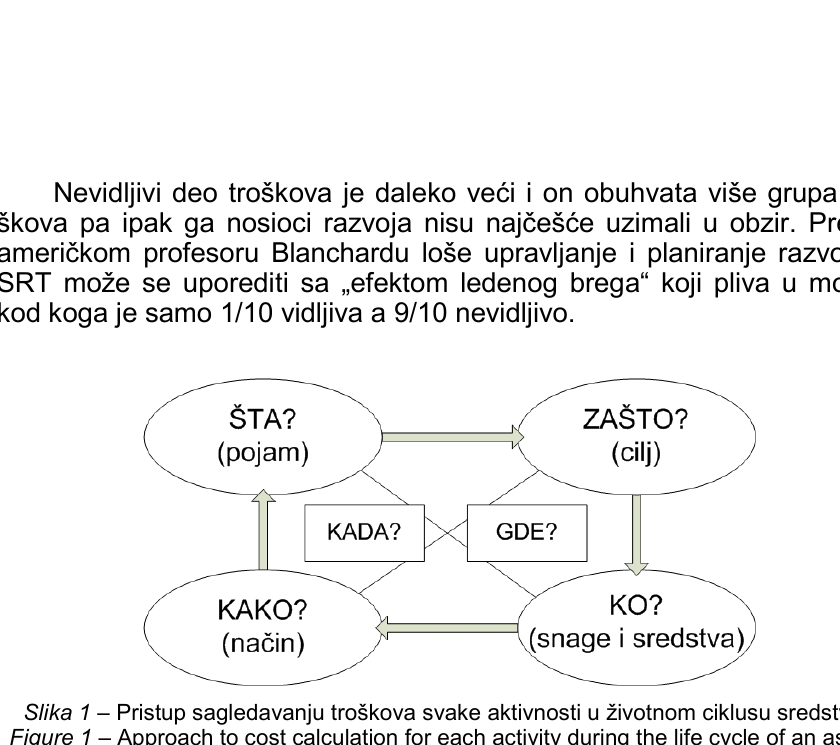
Figure 1 – Approach to cost calculation for each activity during the life cycle of an